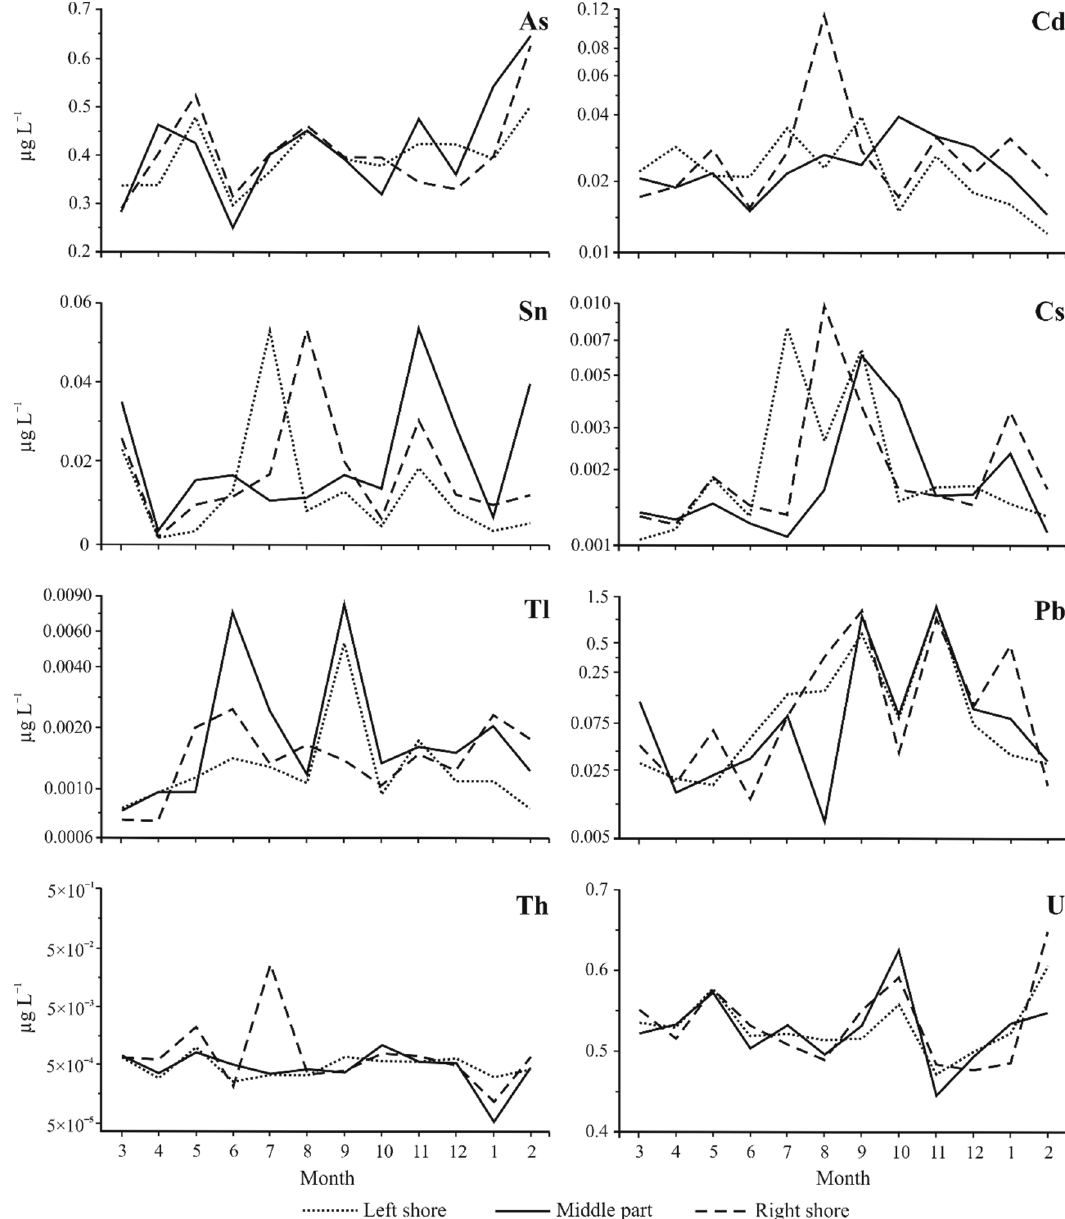
Figure 2. Trace element concentrations ( μ g L − 1 ) in water of the Angara River source (3—March 2021,